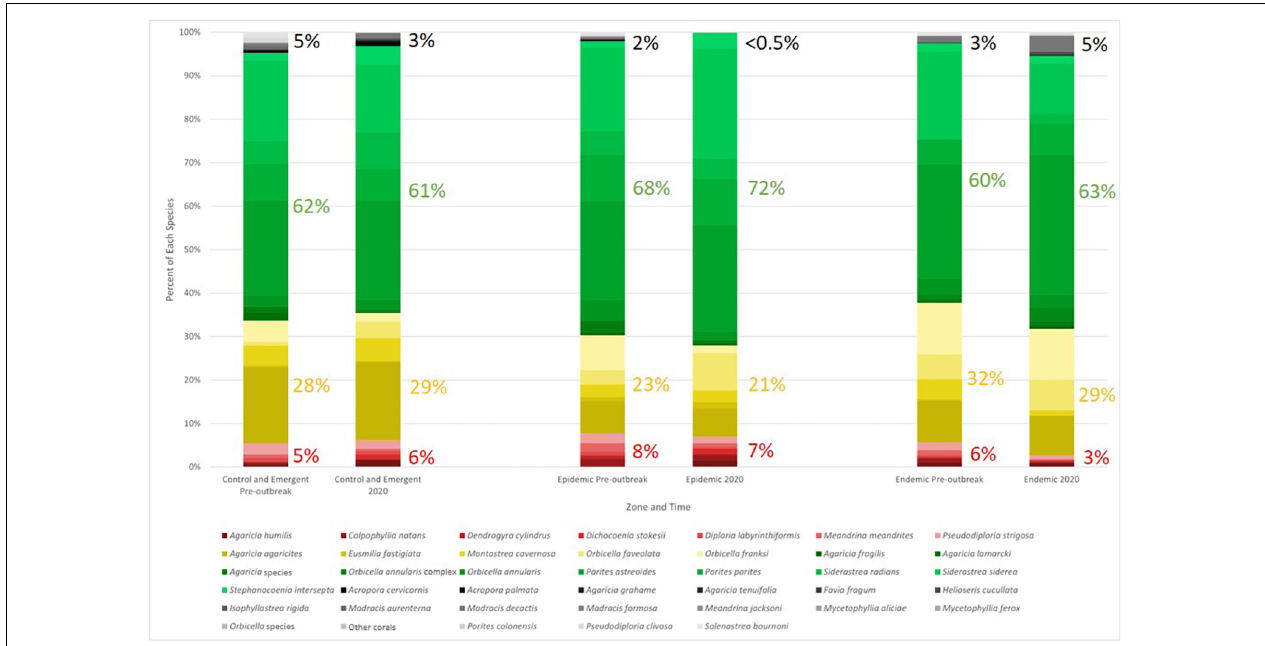
FIGURE 9 | Relative percent community composition by numbers of colonies of each coral species in the zone both pre-outbreak and in 2020. Highly susceptible species are shown in reds, intermediate susceptible species in yellows, low susceptible species in greens, and unknown in grays. Percentages for each of these groupings are shown to the right of the corresponding bar and were rounded to the nearest whole number. Susceptibility classifications are based on the results from this